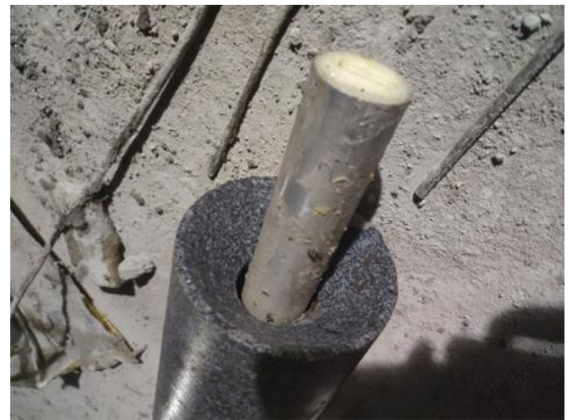
Figure 3. A core that envelops a hollow inclusion.